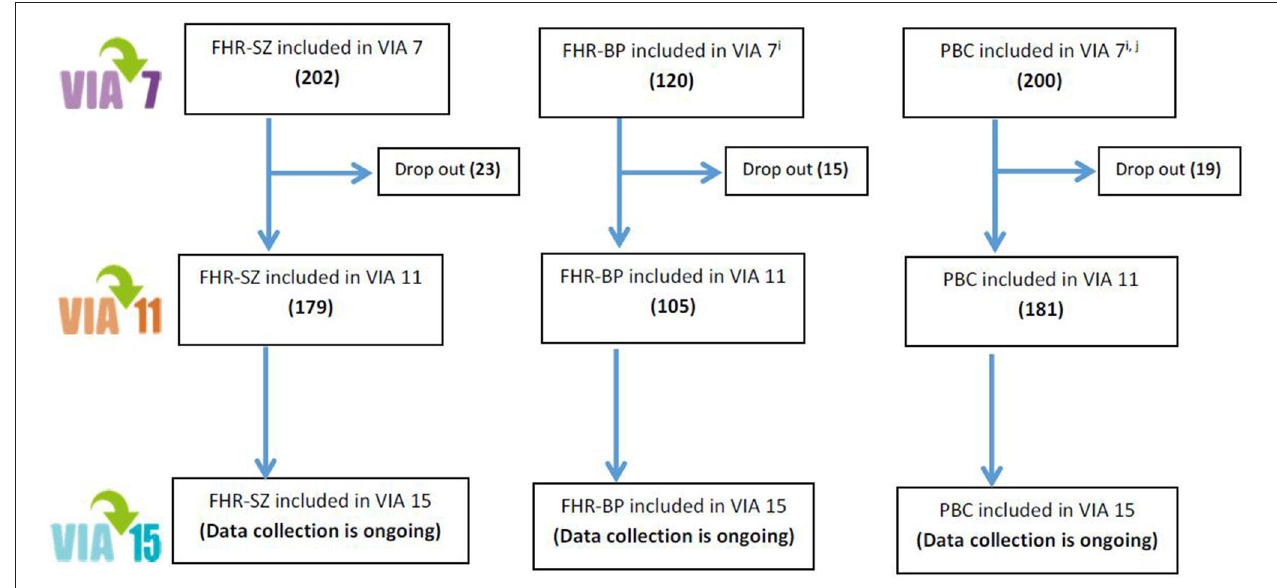
FIGURE 1 | Flowchart of The Danish High-Risk and Resilience